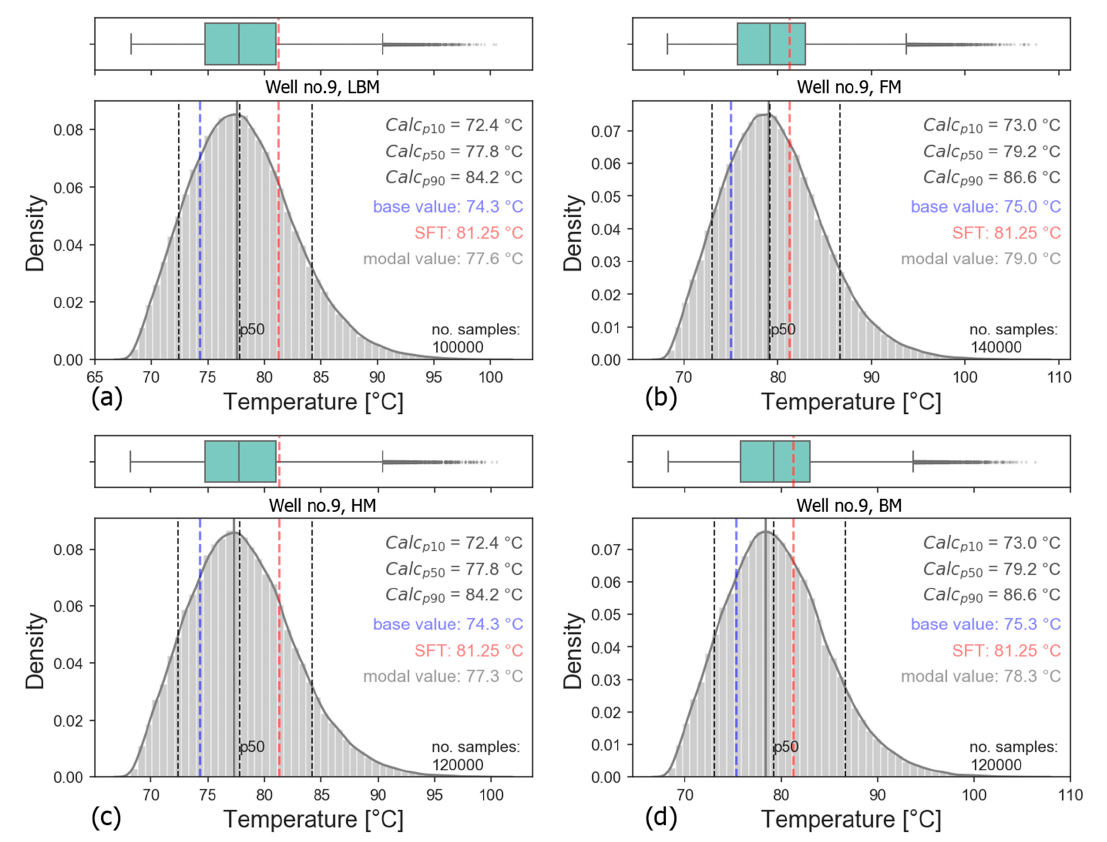
Figure 12. Distribution of corrected SFT at well no. 9 for six conventional methods ( a ): Horner method HM, ( b ): Forward modelling FM, ( c ): Lachenbruch and Brewer method LBM, ( d ): Brennand method BM. The SFT has been estimated from a nearby (2300 m distance) undisturbed TLog with a shut-in time of 2 months. A boxplot is included above every subplot with the SFT as the red dashed line.